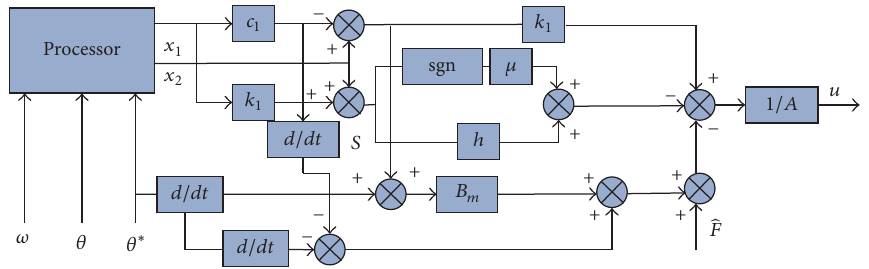
Figure 5: Block of the adaptive sliding mode